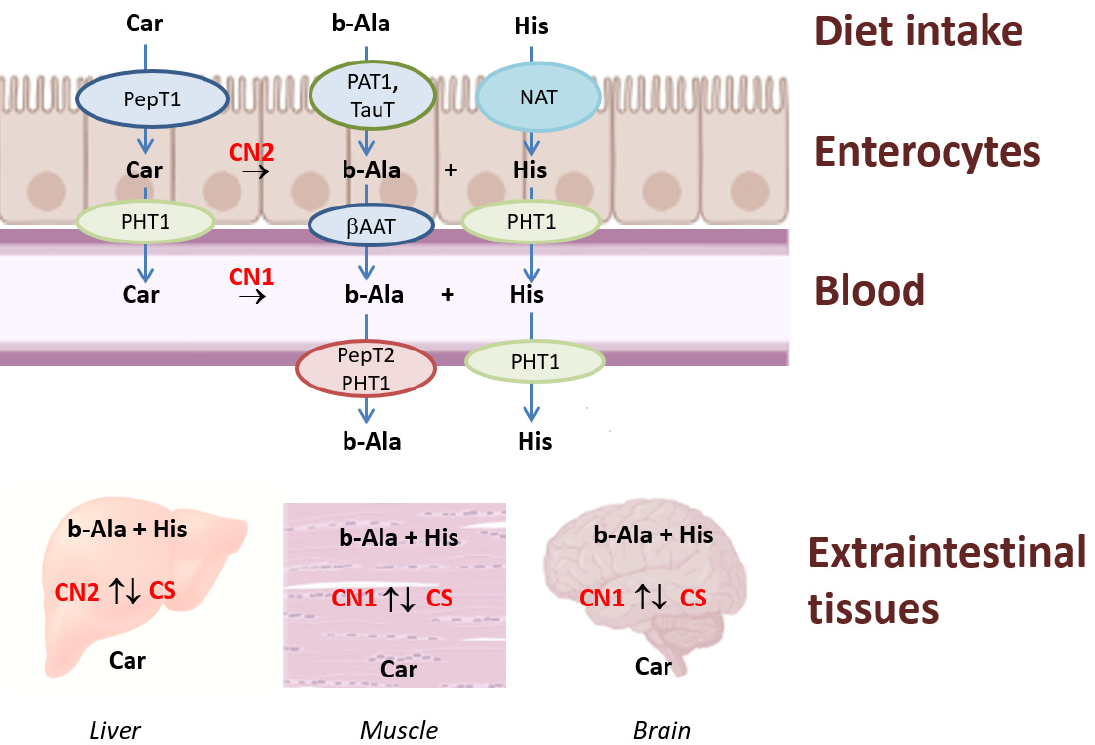
Figure 3. Metabolism of carnosine and beta-alanine. Carnosine (Car) enters the enterocyte by a peptide transporter (PepT1); beta-alanine (b-Ala) enters by a specific transporter for beta-amino acids, a proton-assisted amino acid transporter (PAT1) and a taurine transporter (TauT); and histidine (His) enters by a sodium-dependent neutral amino acid transporter (NAT). Proton-coupled peptide- histidine transporter 2 (PepT2) carnosine transporting is expressed in the membrane on majority extraintestinal tissue. b-Ala is transported from the circulation by beta-amino acid specific transporter (ßAAT) and His by PHT1. In the extraintestinal tissues, carnosine is cleaved by carnosinases CN1 or CN2 into b-Ala and His, respectively, and formed from these two amino acids through carnosine synthetase (CS).